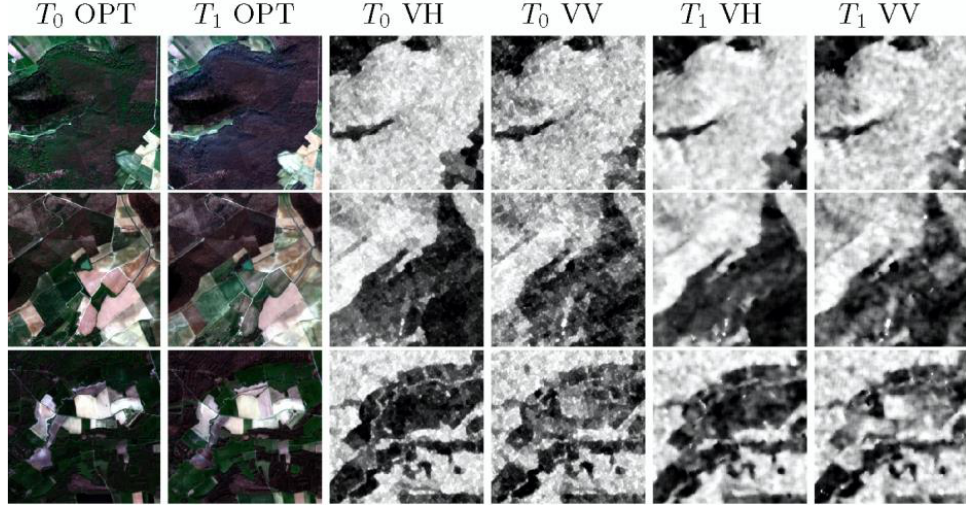
Figure 2. Simple scenario training sample example.